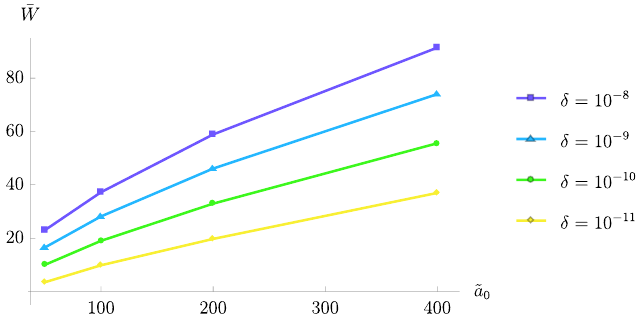
Figure 8 . The suppression rate (cid:22) W as a function of ~ a 0 and for several choices of (cid:14) . One observes the power-like behavior, in agreement with eq. (4.55). The small deviations from the power law are due to a sub-dominant dependence on ~ a 0 and an imperfect separation of the region where ~ a ( (cid:18) ) varies from the region where the quartic derivative term